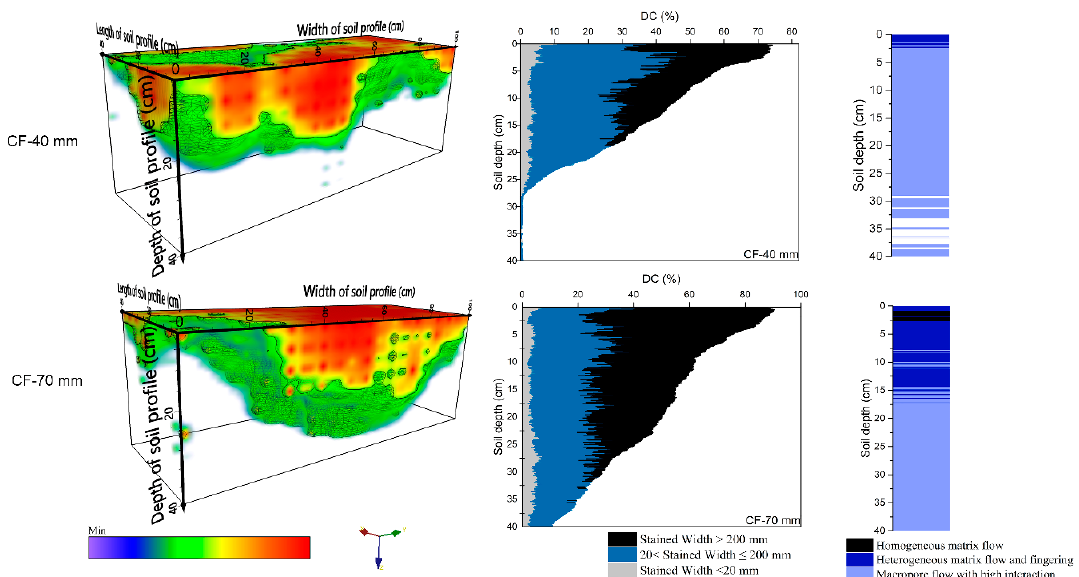
Figure 2. Characteristics of preferential flow ( a ) DC, ( b ) stained width distribution, and ( c ) preferential flow types) at DF and CF sites under large and extreme rainfall events. DF-40 and CF-40 mm were sampled for large rainfall (40 mm). DF-70 and CF-70 mm were sampled for extreme rainfall (70 mm). DF: deciduous forest; CF: coniferous forest; DC: dye coverage (%).